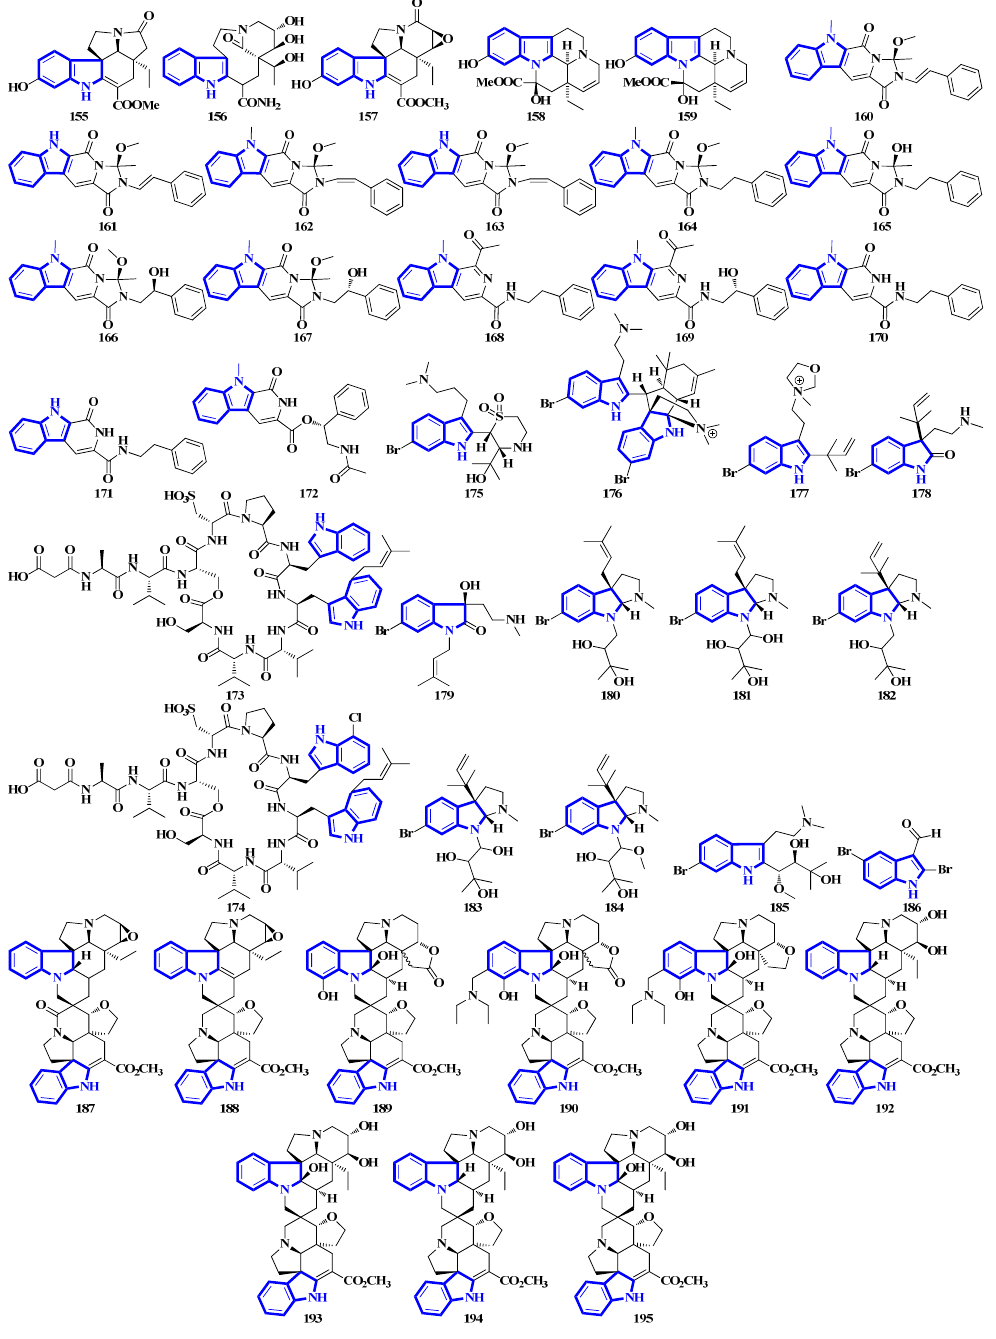
Figure 9. Novel indole alkaloids 155 to 195 . Alkaloids 196 to 200 were isolated from Fusarium obtained from the inner tissue of Acanthaster planci , and compounds 197 and 198 are bisindoles [56]. Compounds 201 to 204